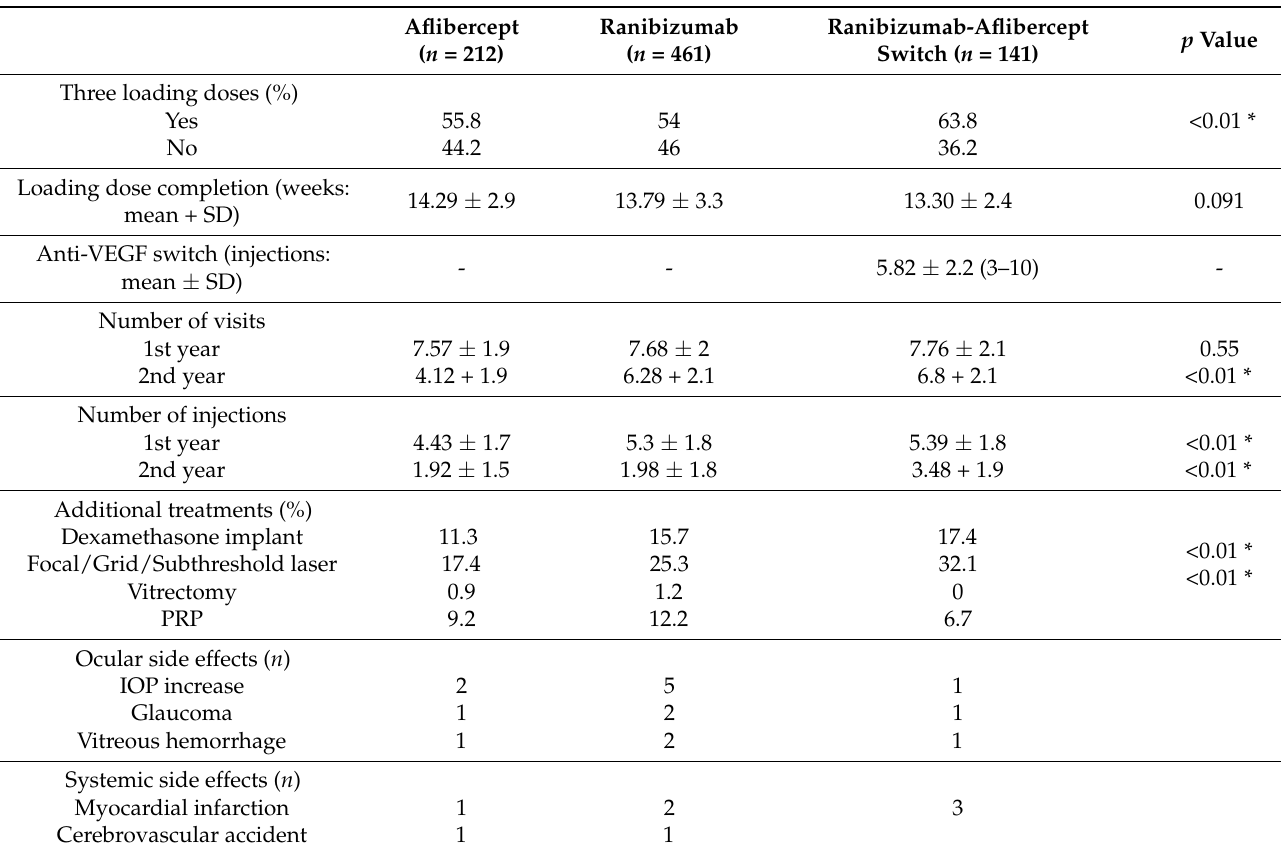
Table 2. Clinical characteristics of the study groups during 2-year follow-up. Aflibercept ( n =